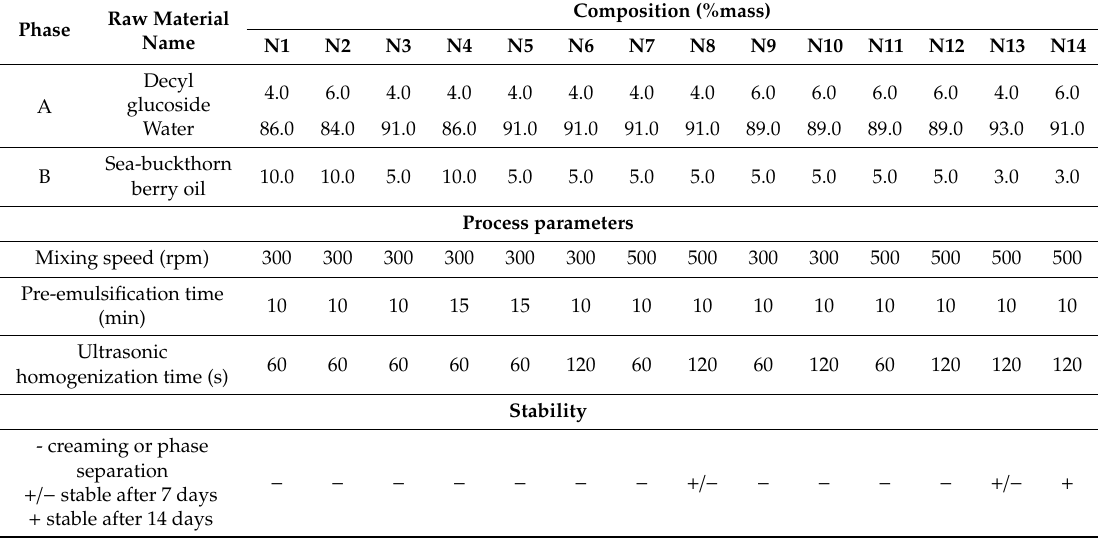
Table 1. The composition and the process parameters of the basic nanoemulsions